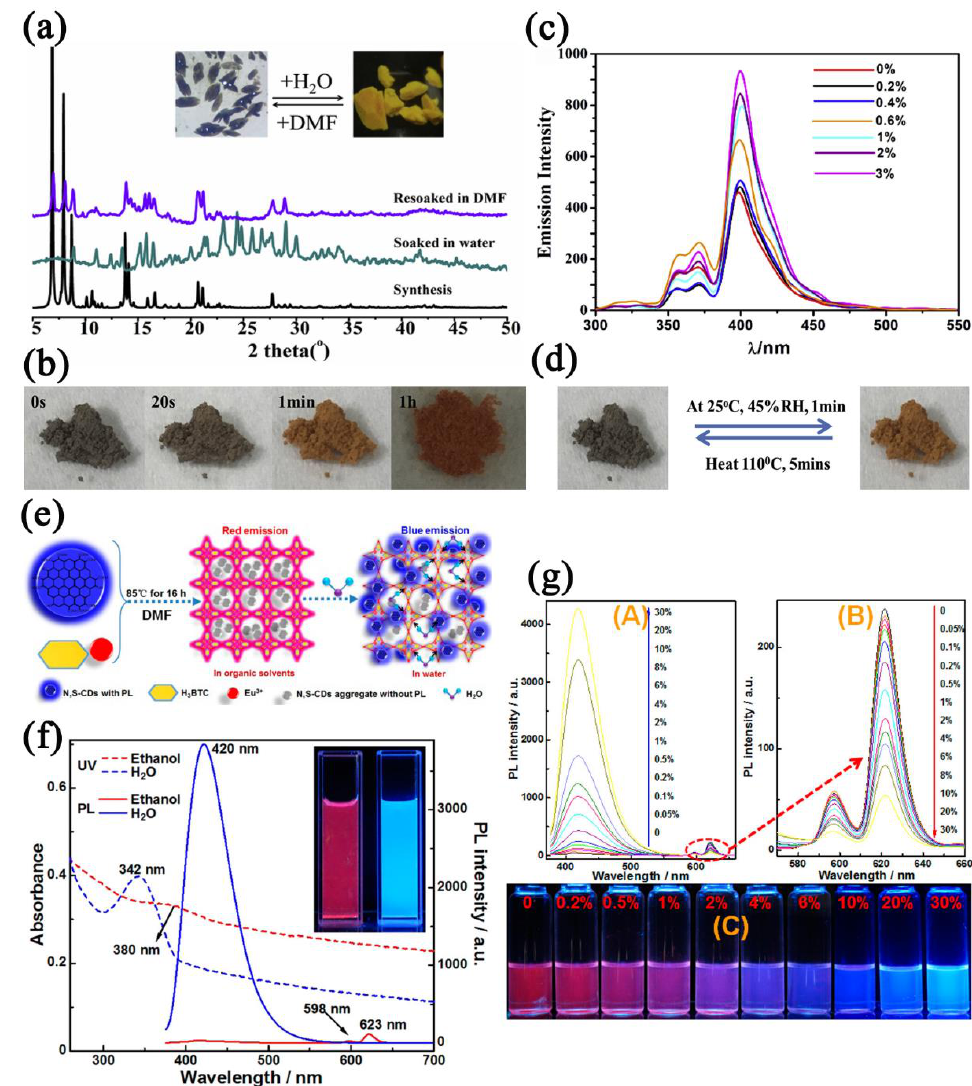
Figure 16. ( a ) XRD patterns and photographs of Co − MOF soaked in DMF and water. ( b ) Photograph images of Co − MOF at 45% RH for different times. ( c ) Luminescent spectrum ( λ ex = 285 nm) of Co − MOF to different water concentrations (0 – 3% v / v ) in DMF. ( d ) Photograph images of reversible color changes of Co − MOF at 45% RH. Reproduced with permission from Ref. [134]. Copyright 2019, Elsevier. ( e ) Schematic of the synthesis of Eu − MOF/N,S − CDs and detection of water in organic solvent ( f ) PL emission spectra, UV − Vis absorption spectra, and photographs of Eu − MOF/N,S − CDs in ethanol and water. ( g ) A for the luminescent spectra ( λ ex = 365 nm) of Eu − MOFs/N,S − CDs under different water concentrations (0 – 30% v / v ) in ethanol, B for the amplification of the red emission peaks in (A), C for the photographs (under 365 nm) of Eu − MOFs/N,S − CDs dispersed in ethanol with various water contents ( v / v ). Reproduced with permission from Ref. [139]. Copyright 2016, American Chemical Society.